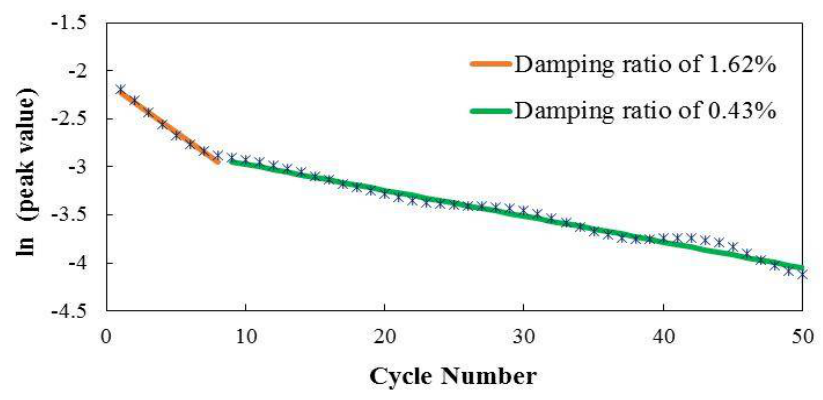
Figure 5. Obtaining damping ratios from the tail-end signal of pedestrian tests.